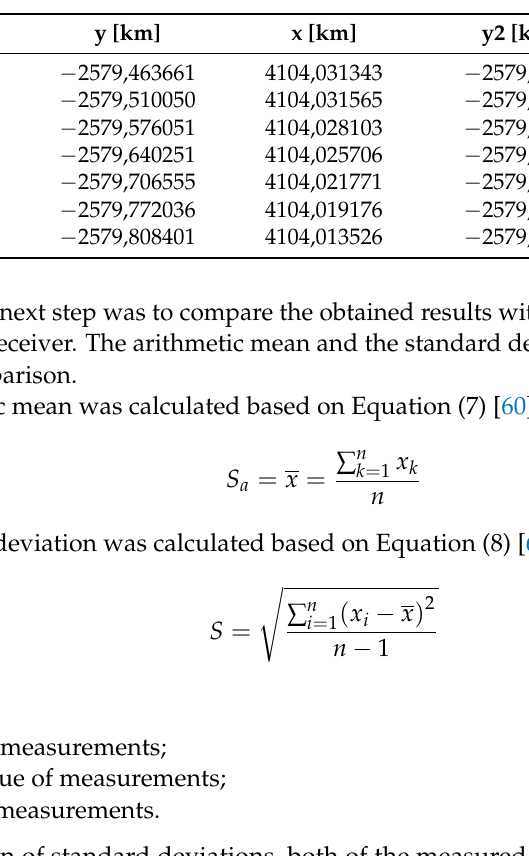
Figure 5. Geographical coordinates conversion, x axis. Table 2. x2, y2 coordinates with assigned time.